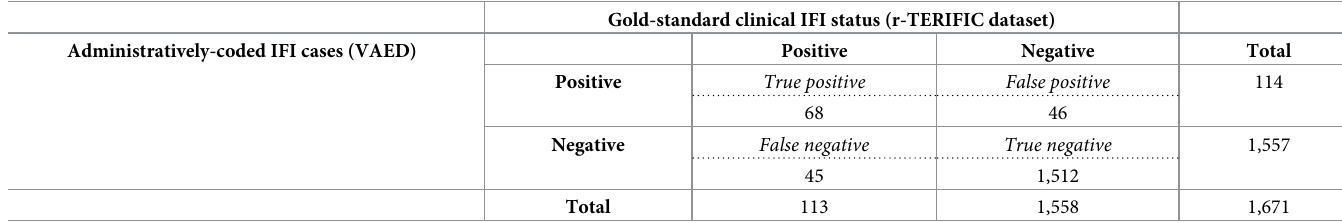
Table 1. Clinical agreement between the gold-standard and administratively-coded cases of invasive fungal infection in the study cohort. Gold-standard clinical IFI status (r-TERIFIC dataset) Administratively-coded IFI cases